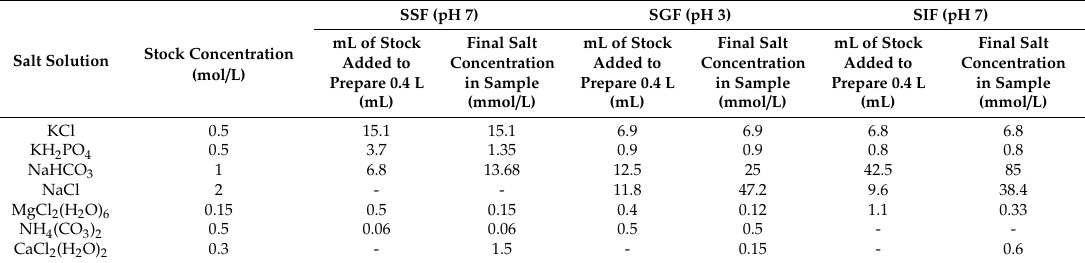
Table 8. Composition of stock solutions of simulated digestion fluid. SSF: simulated salivary fluid, SGF: simulated gastric fluid, and SIF: simulated intestinal